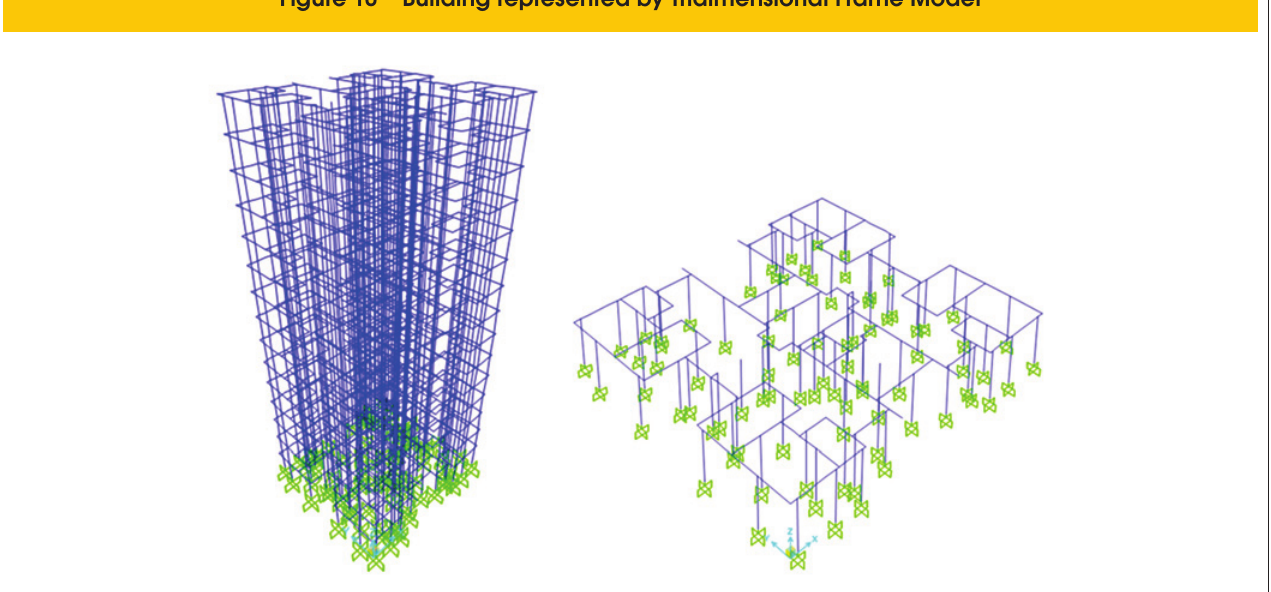
Figure 10 – Building represented by Tridimensional Frame